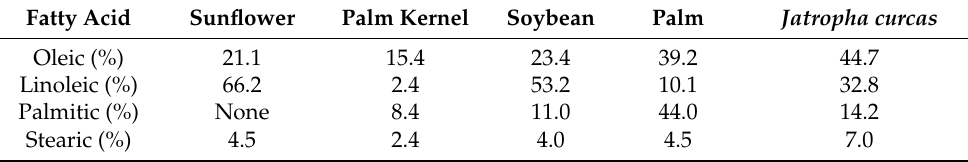
Table 1. Major fatty acid composition (%) of Jatropha curcas oil and other oils